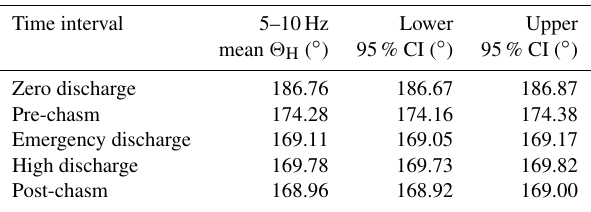
Table 2. Distribution statistics for the mean azimuth within the five time intervals of interest. The 95% confidence intervals (CI) on the mean are determined by collecting 2000 random bootstrap samples with